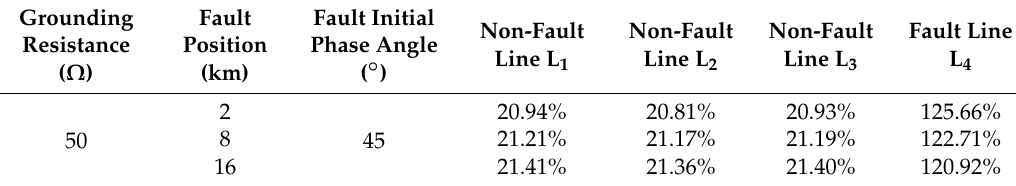
Table 3. The percentage of the DC component in SPG faults under different fault locations. Grounding